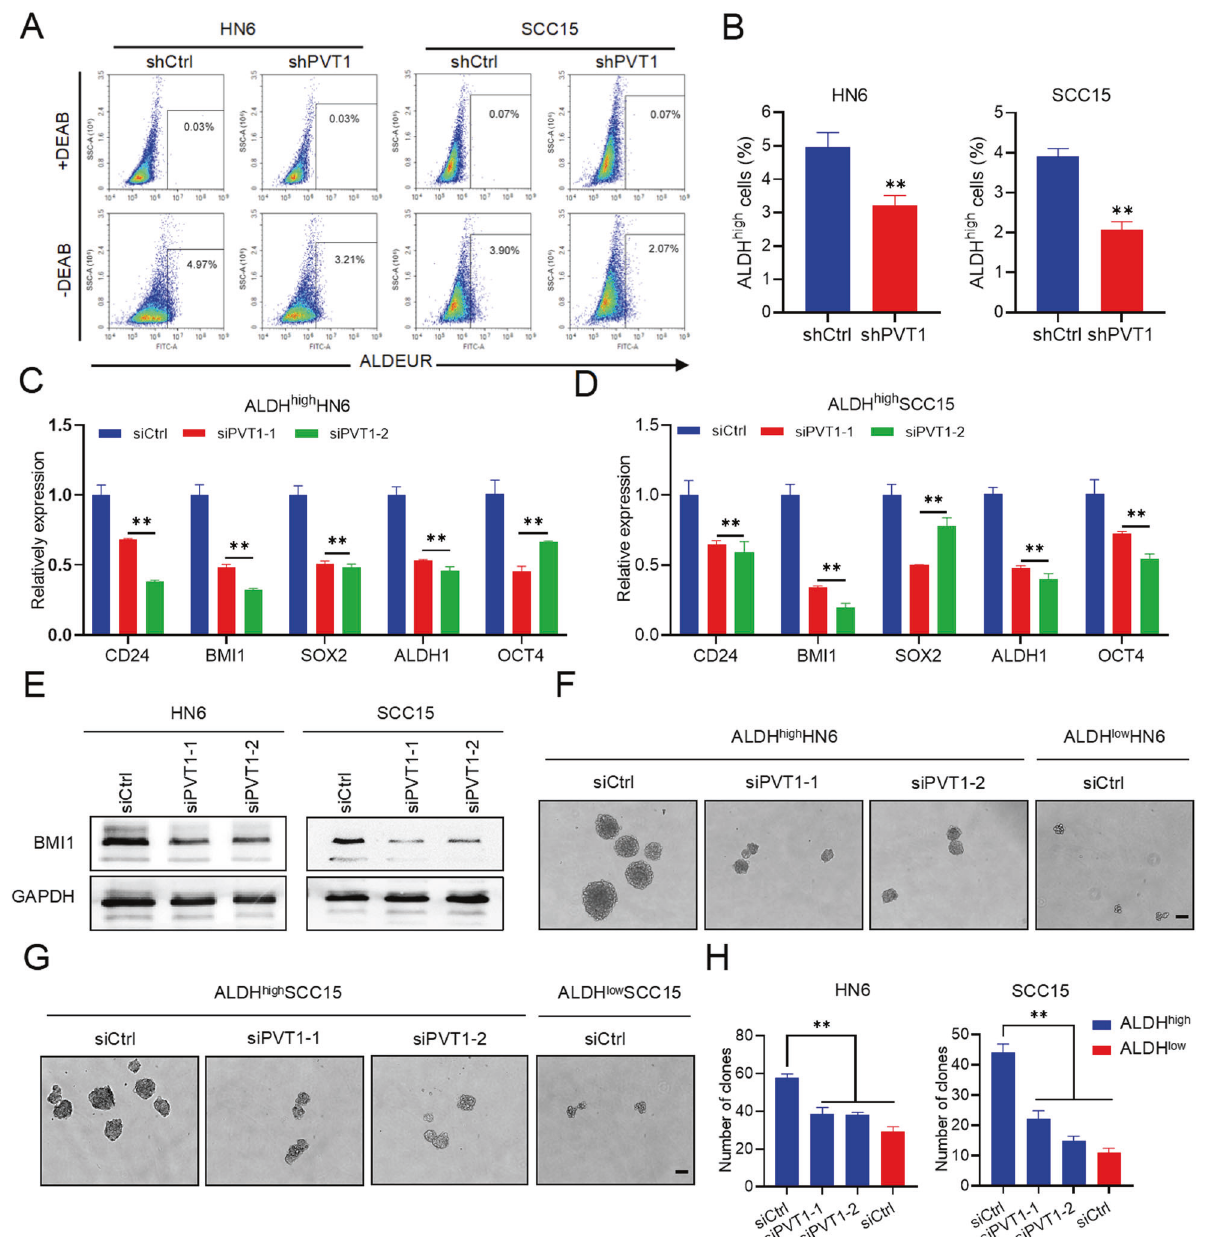
** p < 0.01 using an unpaired Student ’ s